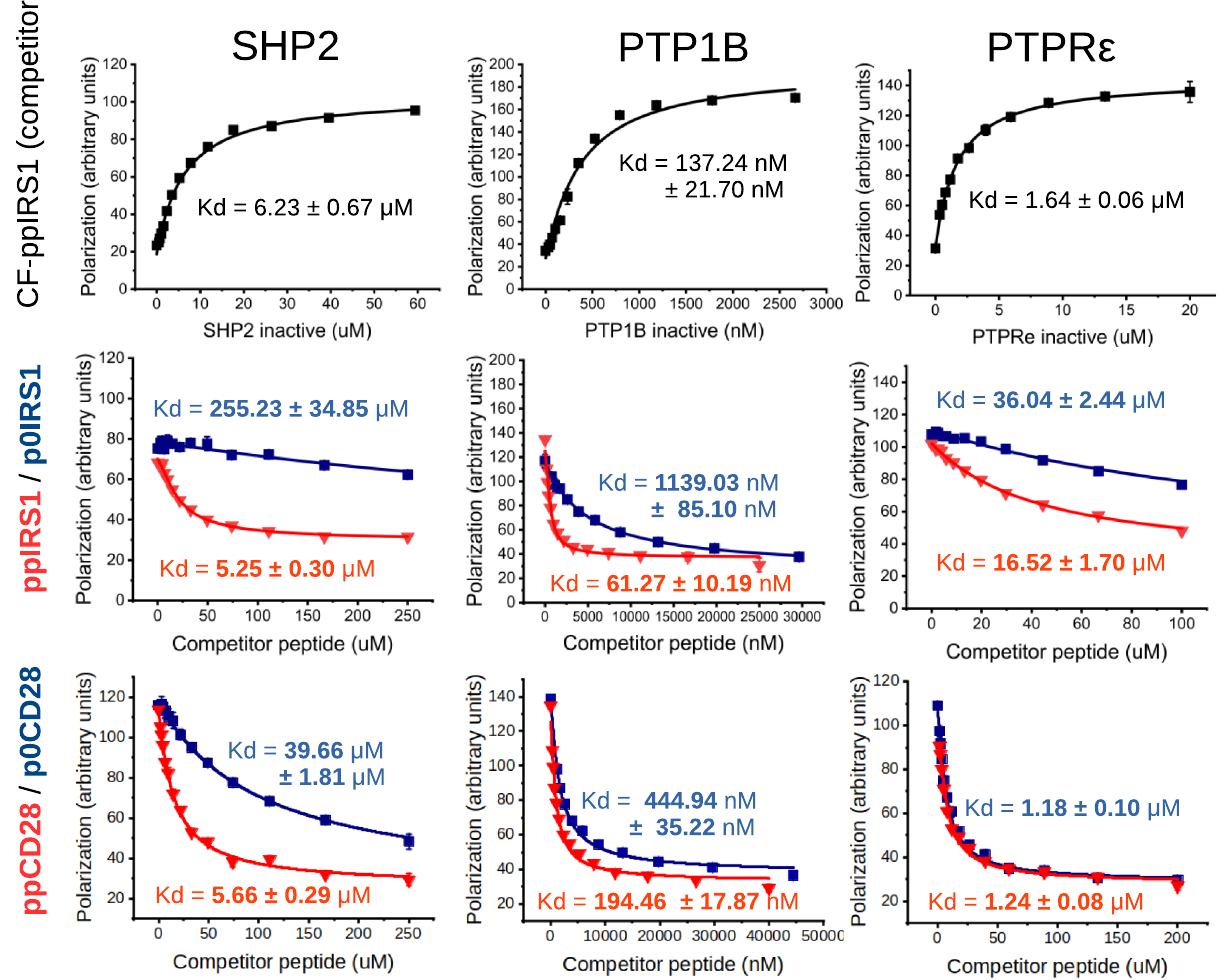
Fig. 2 | Af fi nity measurements of phosphatase substrates. Af fi nity measure- mentsbetweeninactive(Cys → Ser)mutanttyrosinephosphatasedomainsandIRS1 and CD28-derived YxxM[ST]P phosphopeptides ( n =3 technical repeats for each curve showing mean and ±SD for points). The upper lane indicates the direct fl uorescence polarization titrations against a carboxy fl uorescein-labelled pYpS- IRS1 (CF-ppIRS1) peptide (Y632+S636), while the lower lanes show competitive titrations against the matching unlabelled pTyr or pTyr+pSer peptides. The effect